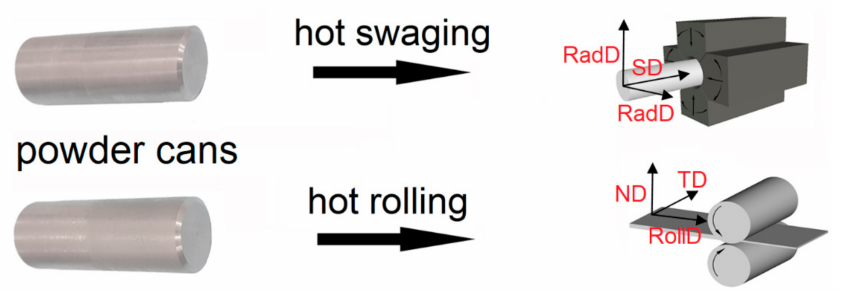
Figure 2. Rolling and swaging geometries used for consolidation of new-generation oxide dispersion-strengthened (ODS)